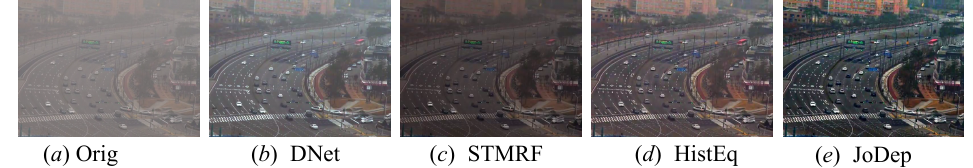
Figure 9. A sample frame from the original video and the defogged images from the four different video defogging